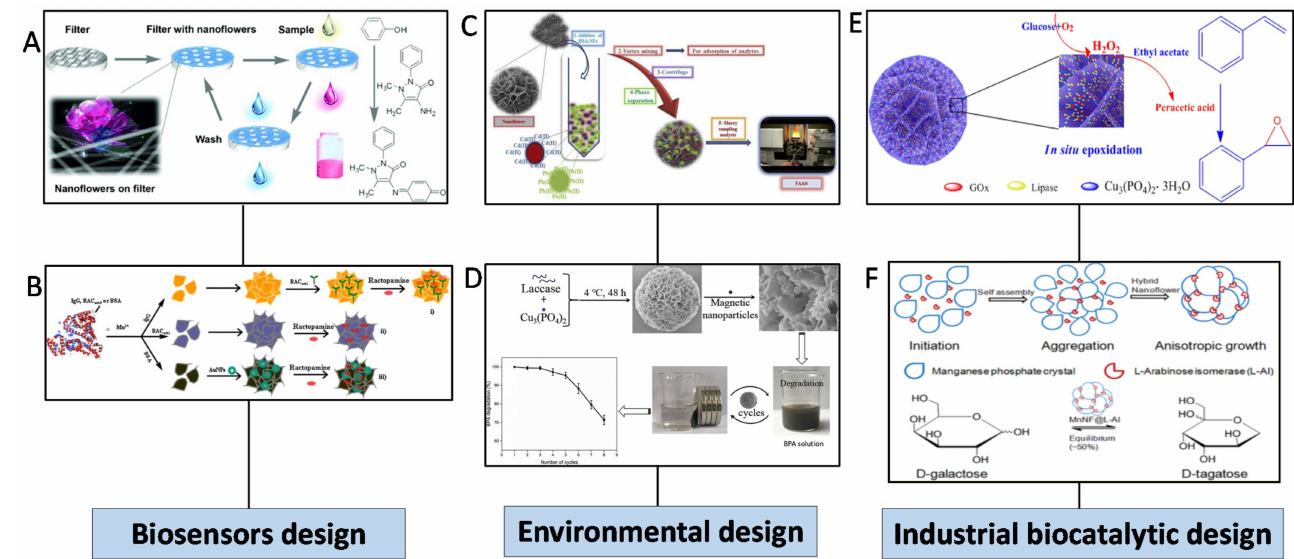
Figure 14. Summary of different applications used for hNFs. ( A ) Fast detection of phenol using laccase/cooper phosphate hNFs integrated into a membrane. Reprinted from [55] with permission from John Wiley and Sons. Copyright © 2021 WILEY-VCH Verlag GmbH and Co. KGaA, Weinheim. License Number: 5031800087304. ( B ) Detection of ractopamine using a protein/manganese ion hNF electrochemical biosensor. Reprinted from [98] with permission from Elsevier. Copyright © 2021 Elsevier B.V. License Number: 5031800271904. ( C ) Selective separation of cadmium and lead in water, cigarette, and hair samples using BSA/copper ions hNFs. Reprinted from [131] with permission from Elsevier. Copyright © 2021 Elsevier B.V. License Number: 5031800434687. ( D ) Degradation of bisphenol A using laccase/cooper phosphate hNFs. Reprinted from [34] with permission from Elsevier. Copyright © 2021 Elsevier B.V. License Number: 5031800600650. ( E ) Epoxidation of alkenes using dual enzyme system GOx and lipase/copper ions hNFs. Reprinted from [77] with permission from Elsevier. Copyright © 2021 Elsevier Ltd. License Number: 5031800753597. ( F ) Transformation of D-Galactose to D-Tagatose using L-Arabinose Isomerase/manganese ions hNFs. Reprinted from [95] with permission from the American Chemical Society. Copyright © 2021 American Chemical